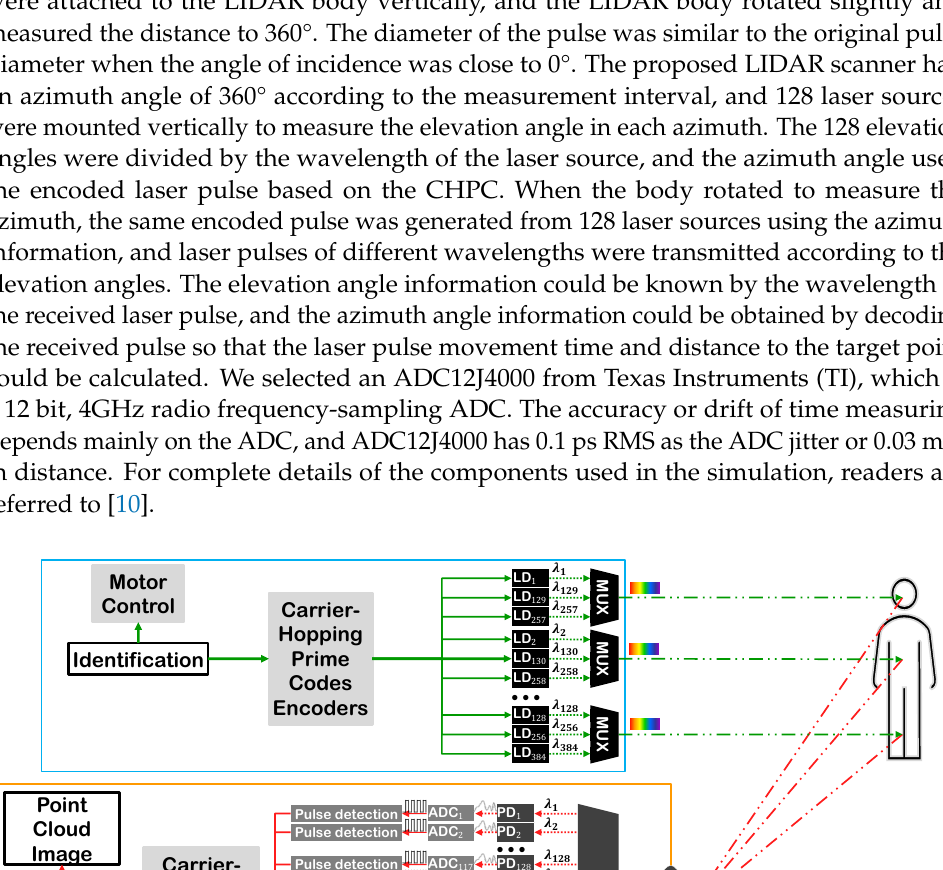
and each of the 128 sources generated encoded laser pulses using three laser diodes (LDs) with different wavelengths. The green color in the figure corresponds to the transmission operations, while the red color is the part that performs the reception operations. The solid line is the path through which the electrical signal is transmitted, and the dotted line is the path through which the laser signal is